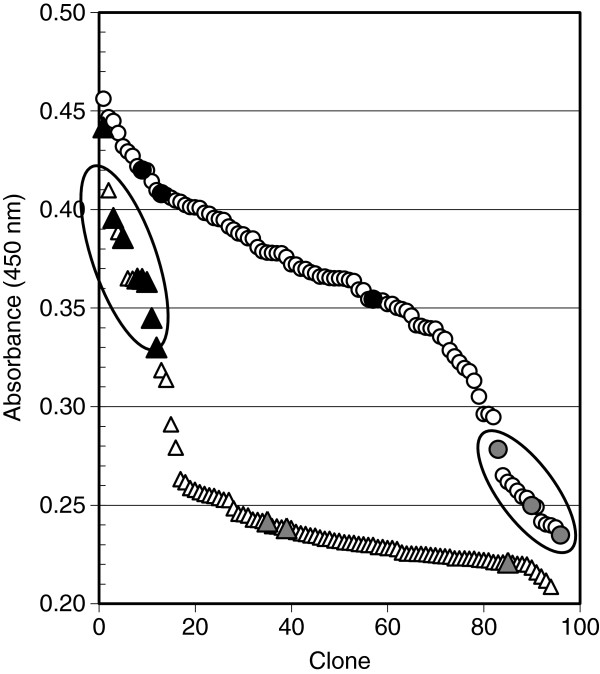
Screening of OST mutant libraries. Sorted ELISA read-outs of 96-well random mutant libraries of PglBCj. Open circles: epPCR mutagenesis of the periplasmic domain (H423-I713), inactive clones selected for anti-HA screening and sequencing marked by an elipsoid. Open triangles: Cassette mutagenesis of I571 and V575 using primers with NDT degeneracy, active clones selected for sequencing marked by an elipsoid. Absorbance at 450 nm was measured against air. Filled symbols: wild-type controls on same plate (pGVXN112Kan), shaded symbols: inactive (mut) controls on same plate (pGVXN113Kan), host strain: E. coli CLM24 (pGVXN150-pGVXN345).